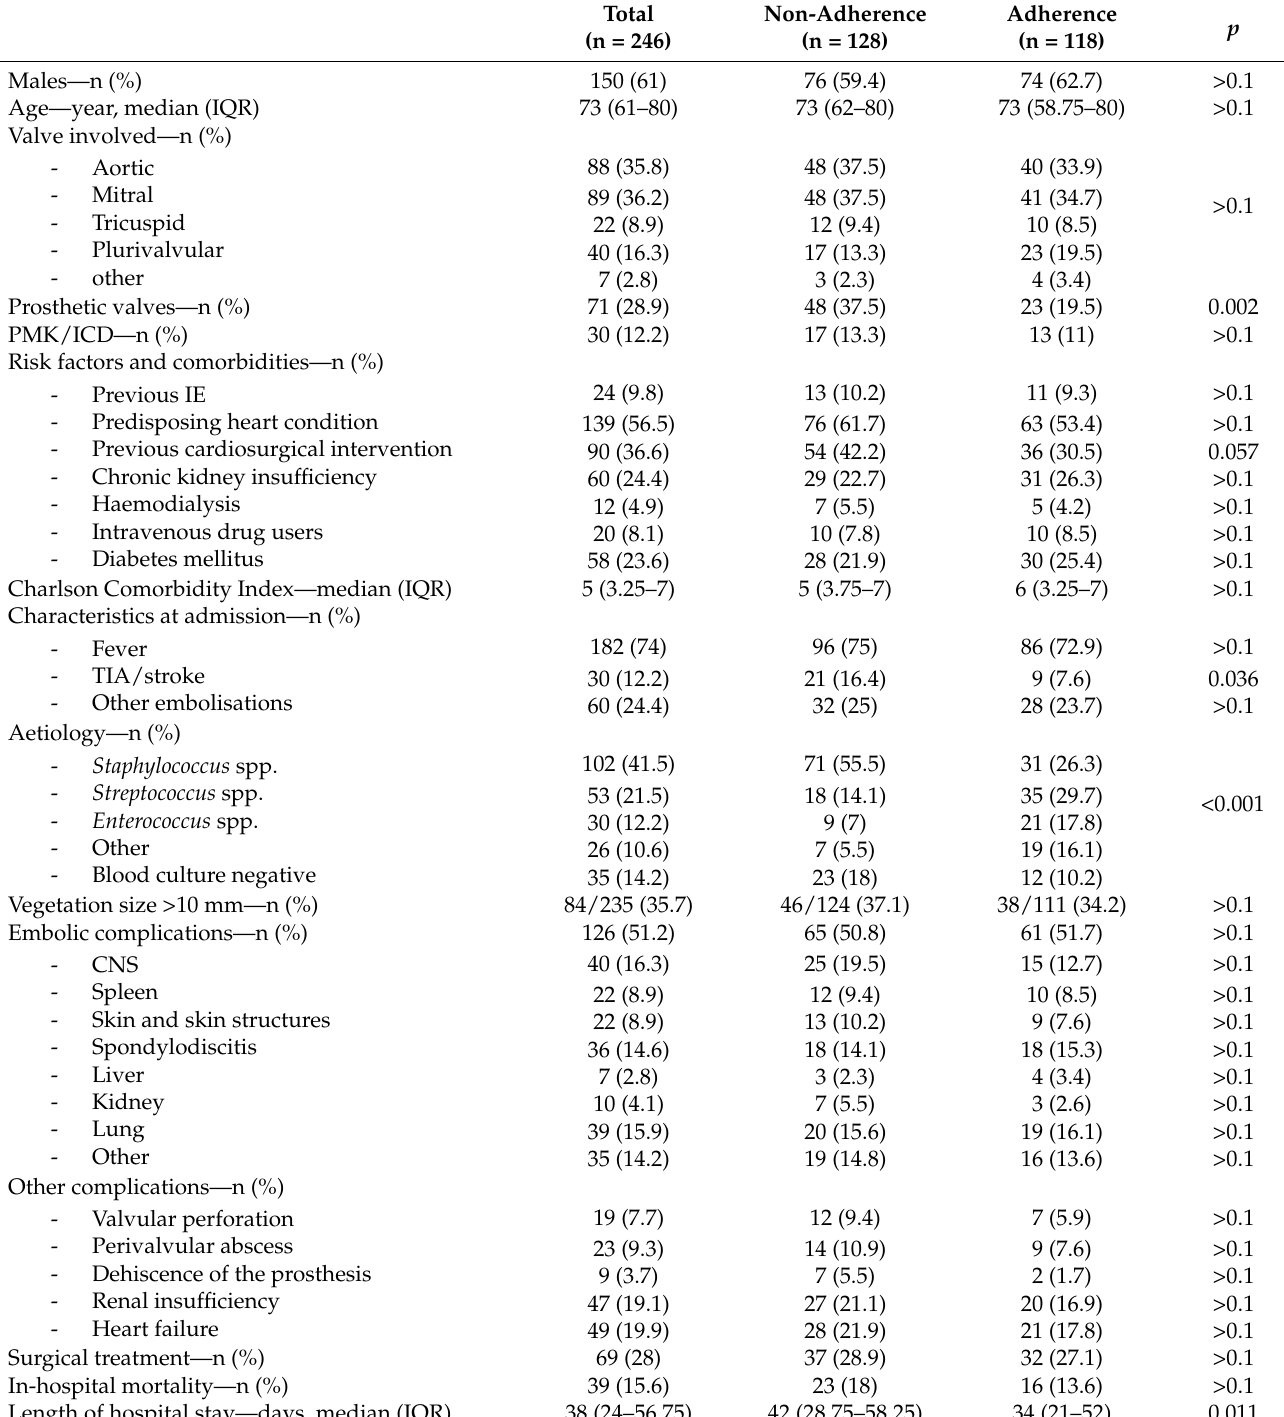
Table 1. Demographic, clinical, and microbiological characteristics and